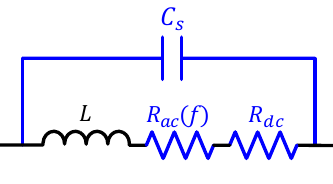
Figure 10. Full winding